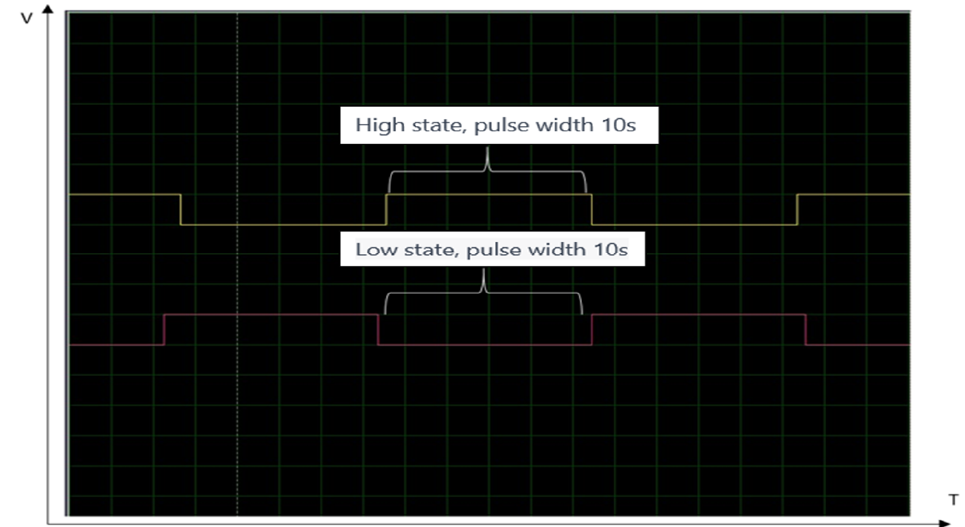
Figure 7. Analog outputs phased in time to control the direction of rotation of the motor.